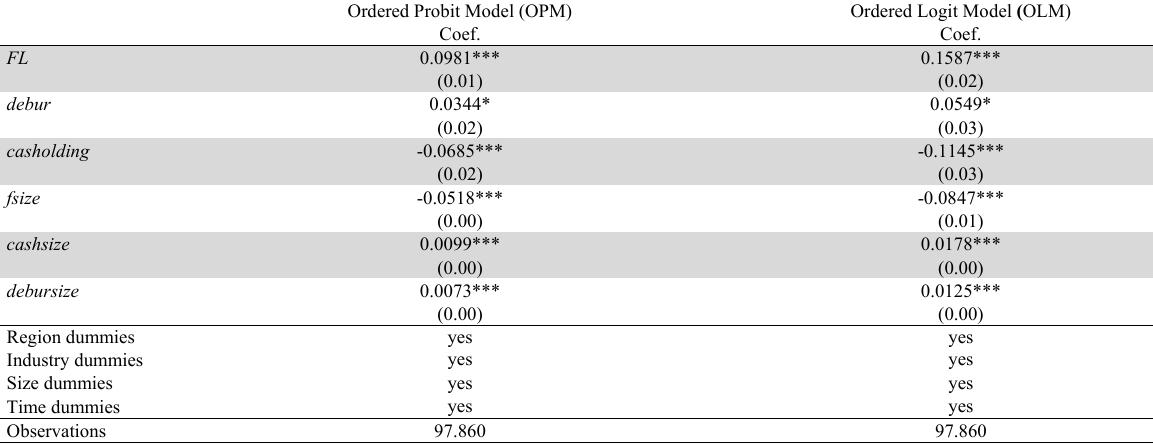
The regression results of Ordered Probit/Logit Model